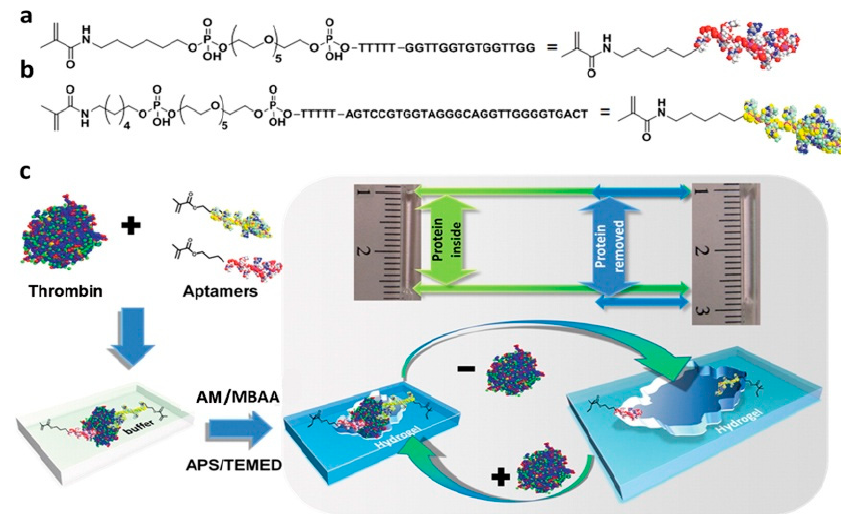
Figure 9. Outline of the biomolecular imprinting scheme used to create superaptamer thrombin-responsive hydrogels. Reprinted with permission from Reference 86. Copyright 2013, ACS.